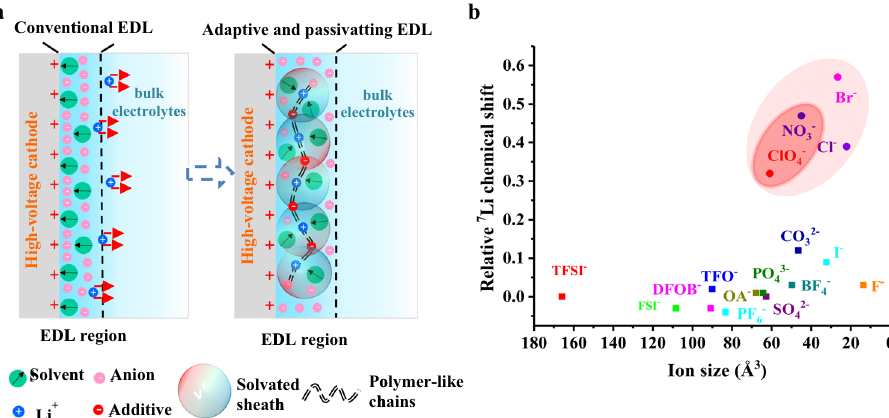
Fig. 1 EDL design strategy and selection of additives. a Proposed mechanism for constructing a dynamic high-voltage resistance EDL. b The selection of stimulus-response additives depends on ion volume and relative 7 Li chemical